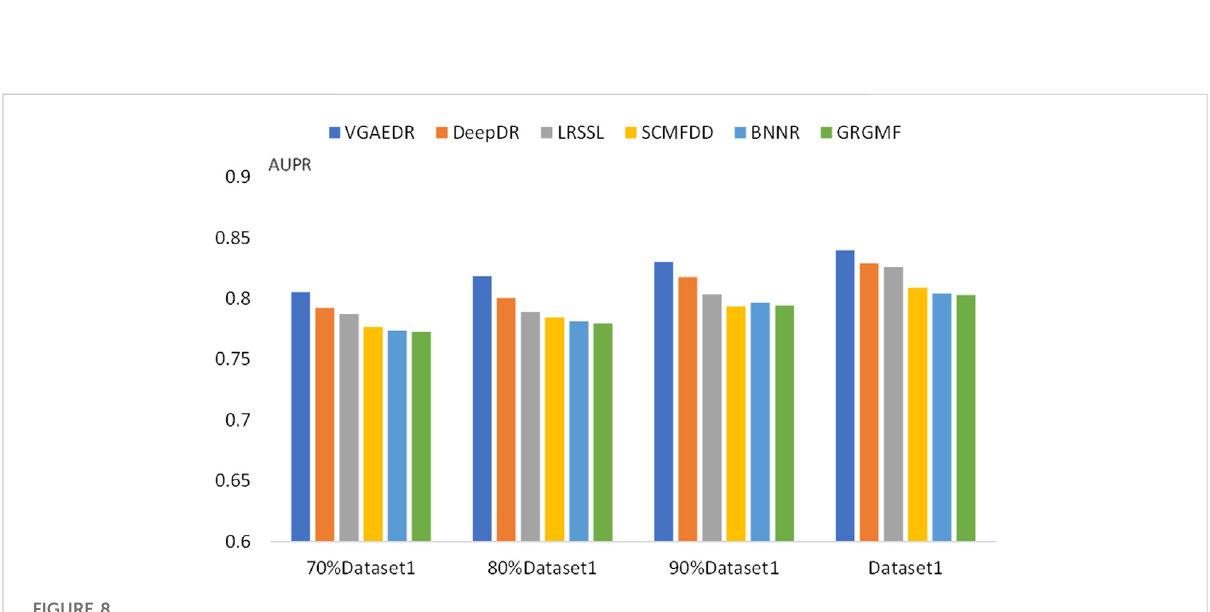
FIGURE 8 AUPR of methods based on different fractions of known